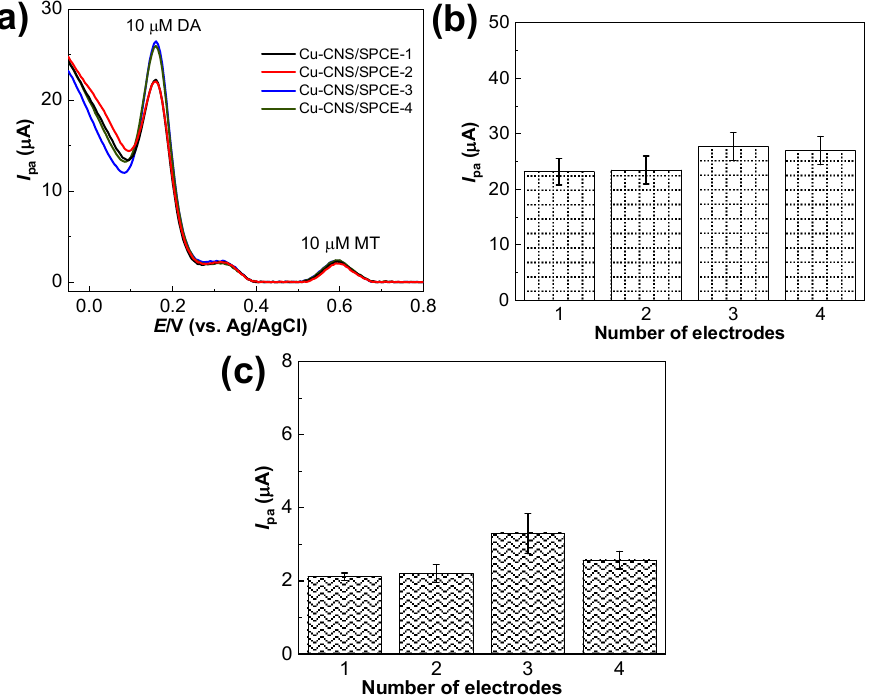
Figure 12. ( a ) Reproducibility results of the four fabricated identical sensors against 10 μM DA and MT. The corresponding plots of I pa values for ( b ) DA and ( c ) MT.